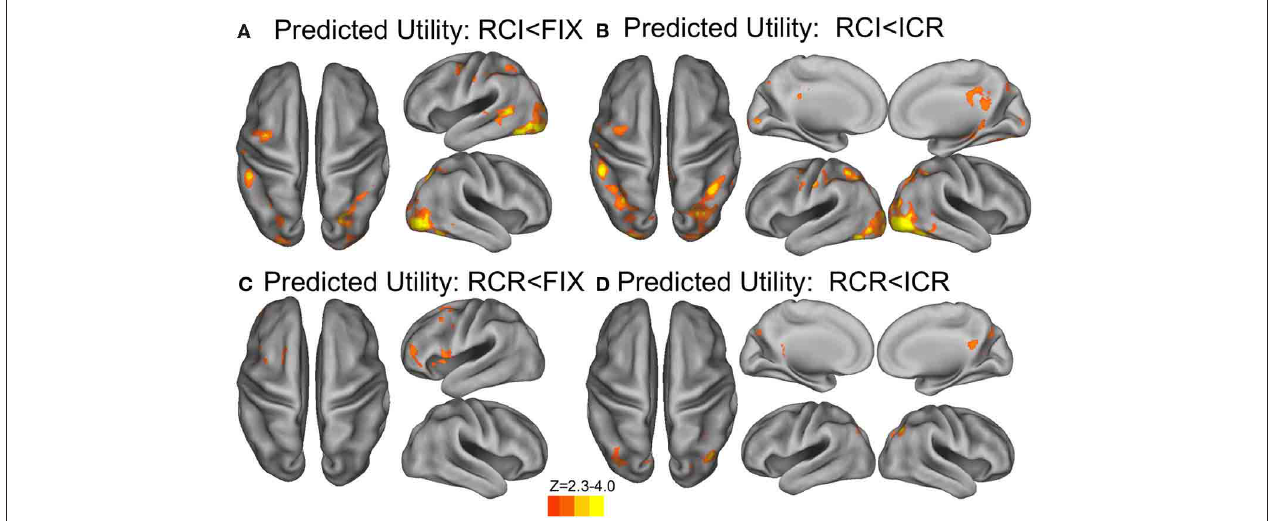
FIGURE 6 | BOLD correlates of model-based Predicted Utility estimates. In the RCI condition, trials associated with lower predicted utility at the presentation of context elicited a reliably stronger BOLD response in visual cortex, anterior intraparietal sulcus, and a region of dorsal premotor cortex, both relative to fixation (A) and relative to the ICR condition (B) . A similar